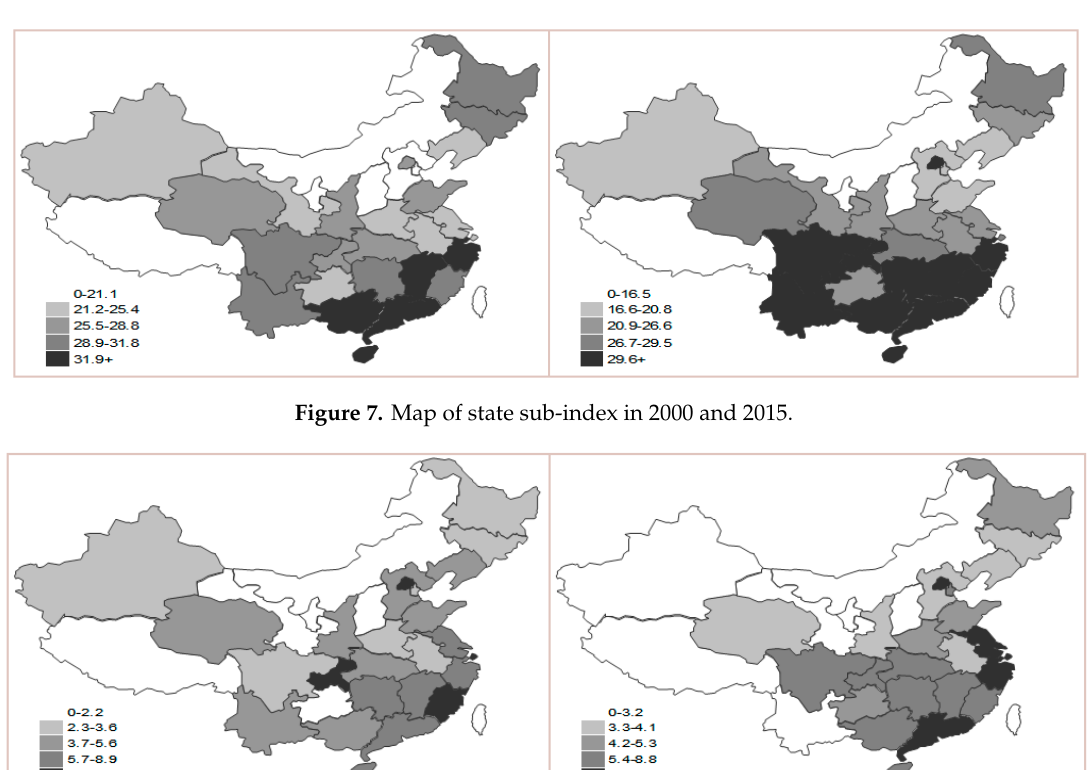
Figure 8. Map of response sub-index in 2000 and 2015.